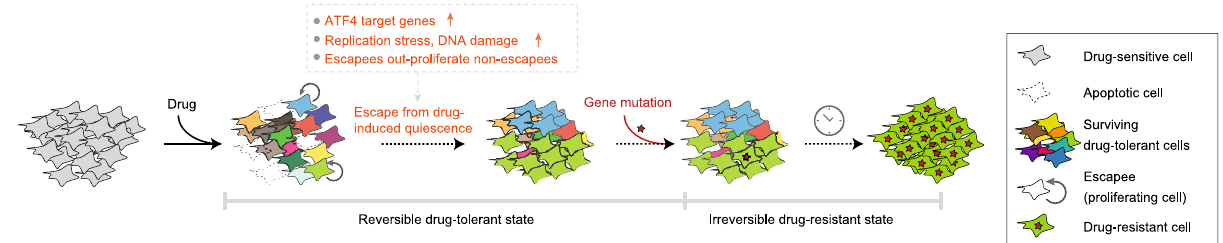
Fig. 8 Model describing how rapid, non-genetic drug adaptation can lead to bona fi de drug resistance. Dabrafenib-treated melanoma cells initially use non-genetic mechanisms, such as ATF4 stress signalling, to adapt to and escape from drug-induced quiescence. These early drug-adapted escapees incur DNA damage while cycling in drug, yet out-proliferate non-escapees over extended drug treatment. Thus, escapees are more likely than non-escapees to acquire the genetic mutations that lead to permanent drug